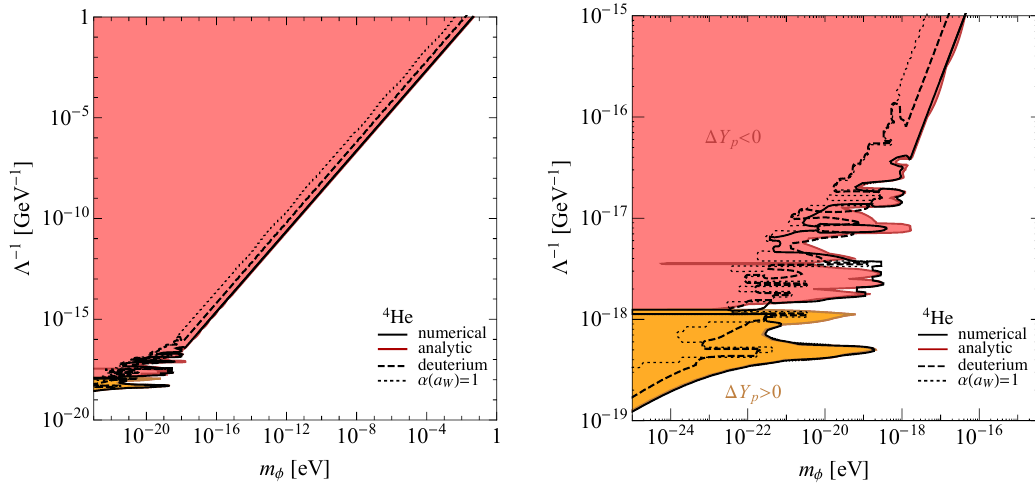
Figure 4 : The numerical constraints on 4 He (black, solid) and D (black, dashed) derived using AlterBBN as compared to the constraints from the analytical approximation of the preceding section (red and orange regions). Again, red corresponds to underproduction of 4 He and orange corresponds to its overproduction. Deuterium tends to be overproduced. The black dotted line delimits the region of parameters where the coupling becomes large at the scale factor a = 10 − 9 . 6 corresponding to the weak freeze-out, α ( a ) > 1 . To the W W left of this line higher-order terms in the Taylor expansion of the function α ( φ ) become important. The right panel zooms in to the region where the constraints exhibit oscillations. Here, the constraints should be taken with caution as they are sensitive to non-linear effects in α